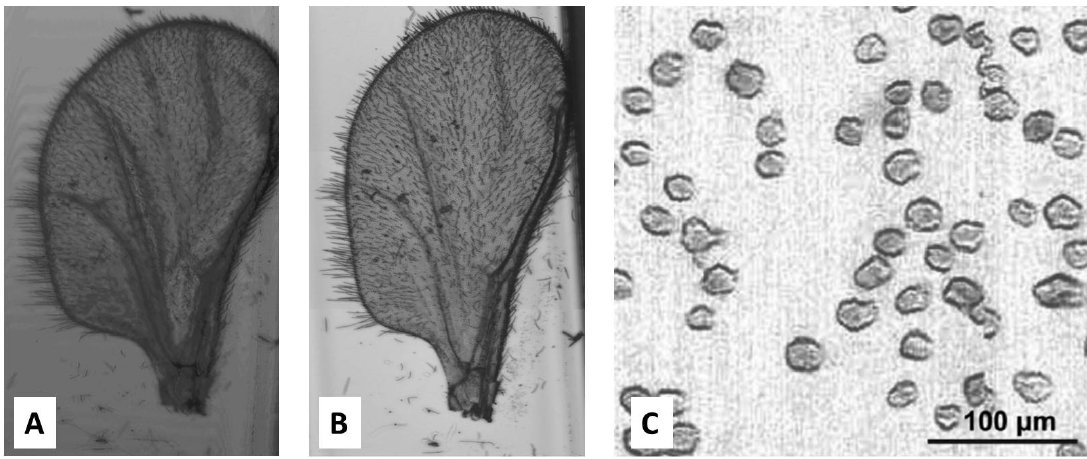
Figure 8. Comparison of images of a gnat wing obtained from ( A ) a CD-based system as a microscope and ( B ) a conventional bright field laboratory microscope. Adapted with permission of Taylor & Francis from [108]. ( C ) Demonstration of CD player as a diagnostic microscopy tool showing imaging of T2 cells (CD4+ and CD8-). Reproduced in part from [107] with permission of The Royal Society of